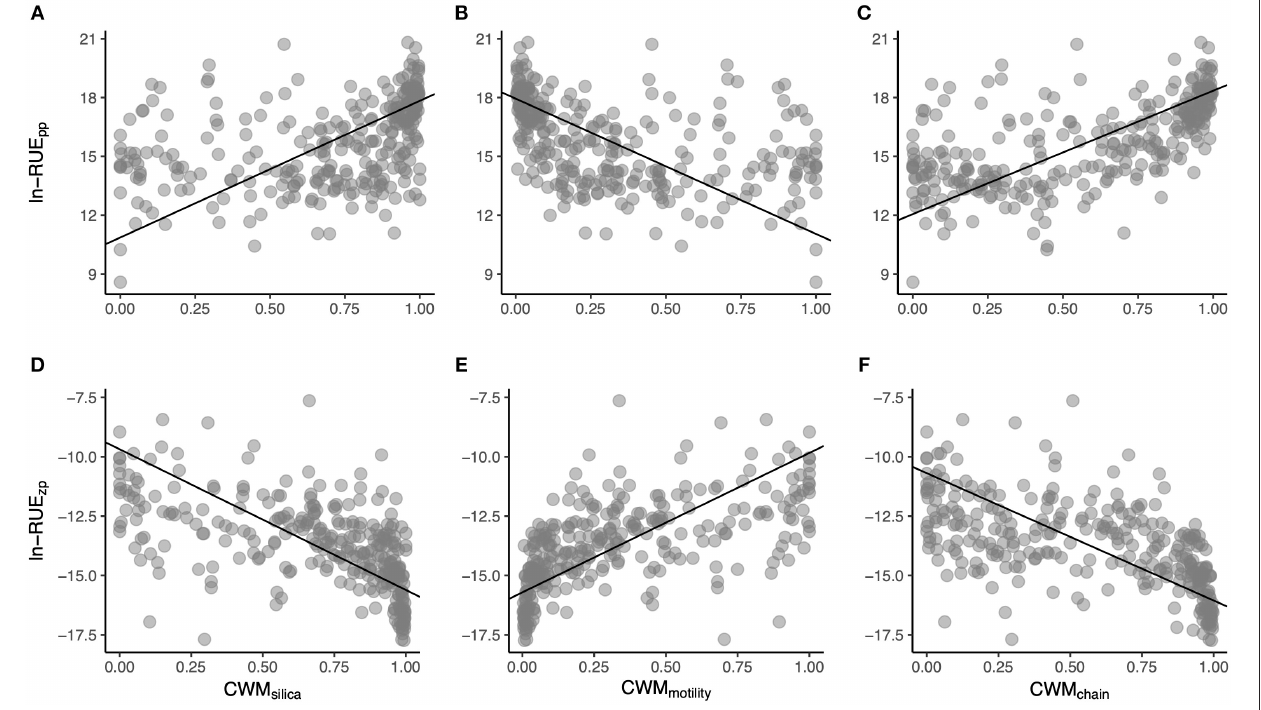
FIGURE 6 | Scatterplots showing the relationships between RUE pp (A–C) and RUE zp (D–F) with CWM silica (A,D) , CWM motility (B,E) , and CWM chain (C,F) . Lines show RMA fits, and corresponding numerical data are provided in Supplementary Table 6